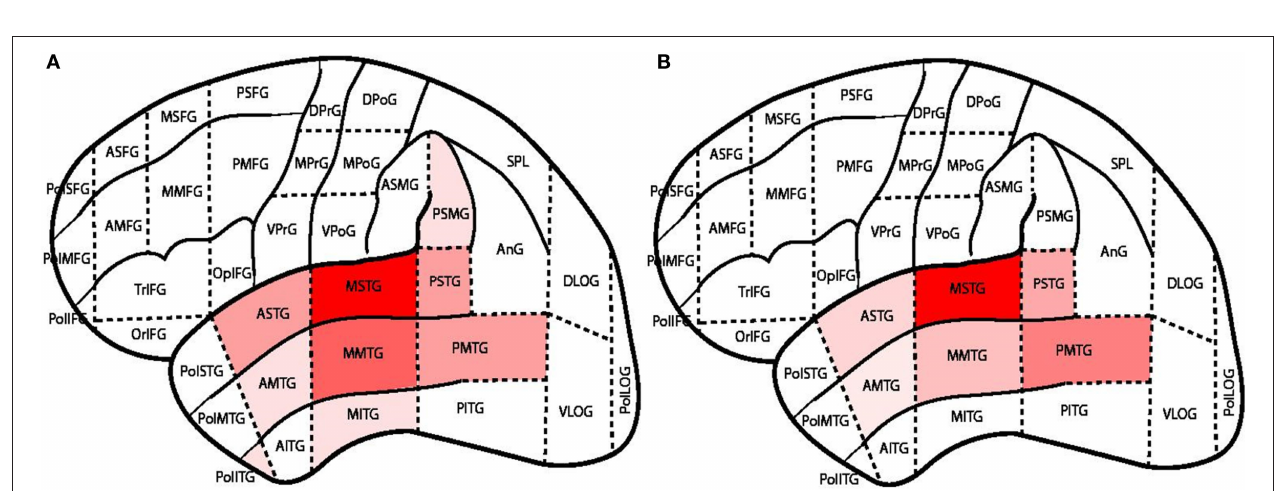
FIGURE 7 | 2-D image output. Intensity of colored regions is proportional to the number of sites in that region returned by the query. (A) Females, (B)